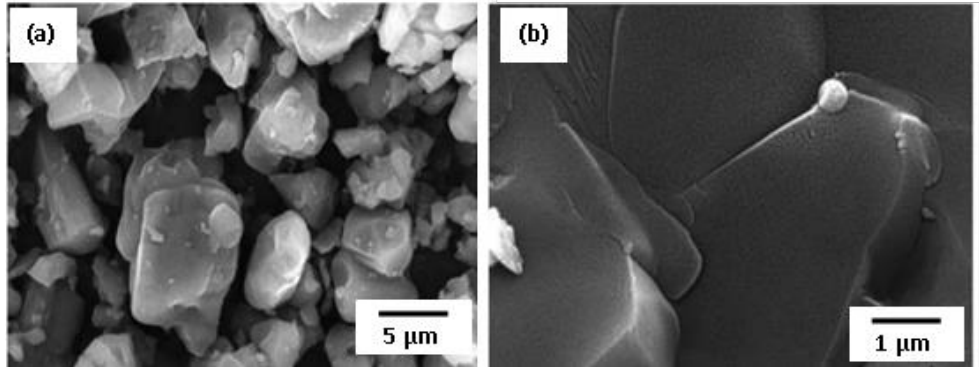
Figure 7. FE-SEM image of as-synthesized single-phase b-SiAlON ( a ) and fractured surface of b- SiAlON sintered at 1600 ◦ C ( b ). Reprinted with permission from Shahien et al. (2008), Copyright 2008, Journal of the Society of Materials Science, Japan